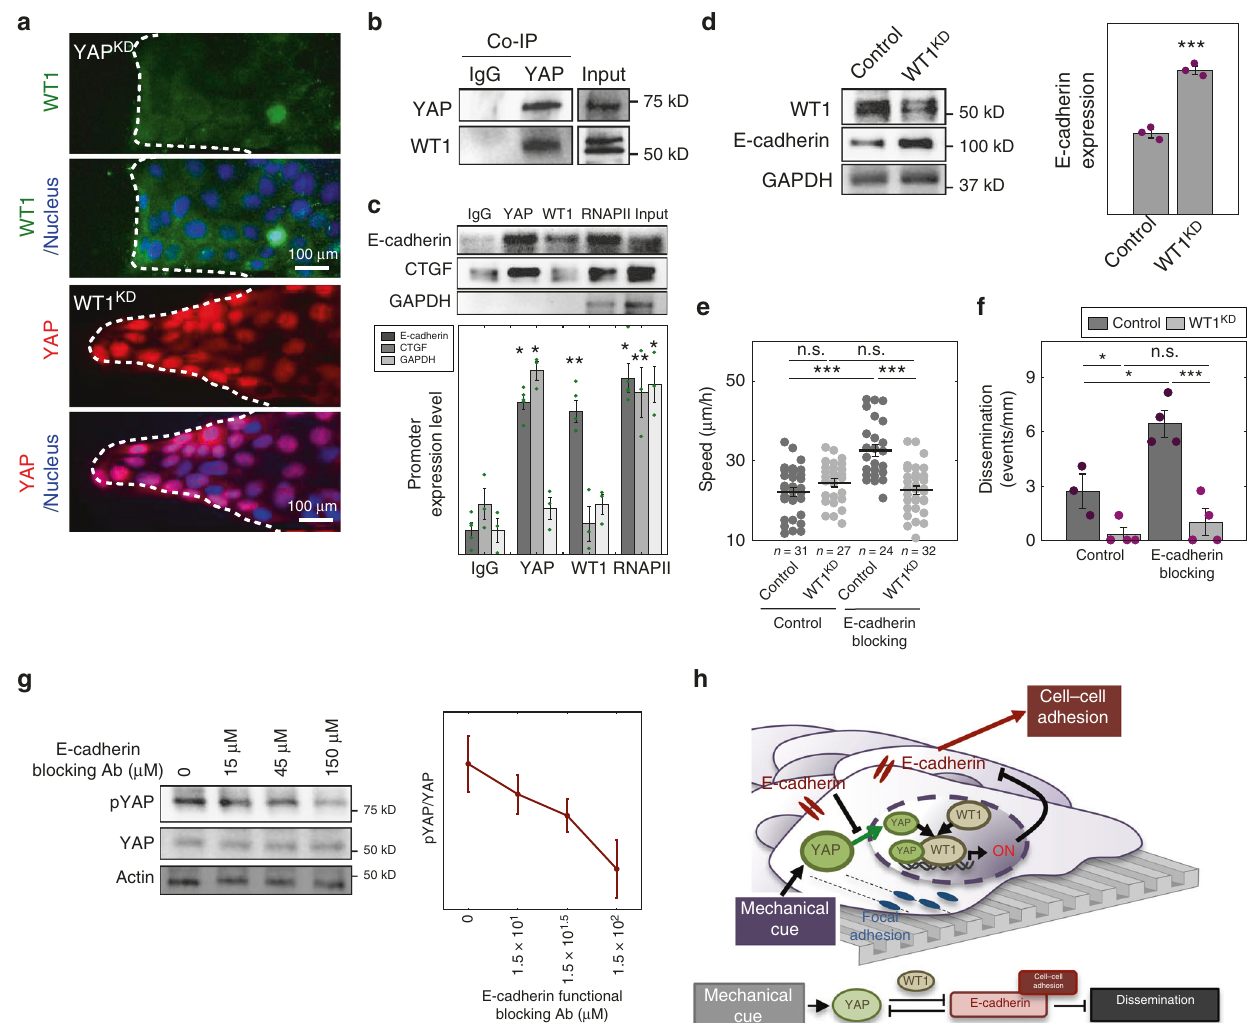
Fig. 4 YAP regulates E-cadherin through WT1 in epithelial layers on NRA. a Immuno fl uorescence staining for WT1 in YAP KD cell sheets (top), and for YAP in WT1 KD cell sheets cultured on NRA. The samples were fi xed after 8 h to remove stencils. b Co-IP analysis using the YAP antibody, followed by immunoblotting using the WT1 antibody. c Chromatin immunoprecipitation (ChIP) analysis of the WT1-YAP complex binding at the E-cadherin promoter ( n = 3). We extracted cross-linked chromatin and immunoprecipitated it using antibodies against YAP, WT1, IgG (negative control), and RNAPII or histone H3 (see Supplementary Fig. 12a) antibodies (positive controls). The immunoprecipitated chromatin and input genomic DNA were used for ampli fi cation of the E-cadherin promoter, CTGF promoter (known to be regulated by YAP but not WT1, and used as another control), and GAPDH promoter ( n = 4 biologically independent samples, * = statistical signi fi cance of PCR products from each sample vs. IgG, * P < 0.05 and ** P < 0.01). d E-cadherin expressions of control and WT1 KD cells analyzed by immunoblotting with WT1 and E-cadherin antibodies ( n = 3 biologically independent samples, * = statistical signi fi cance of E-cadherin expression of control and WT1 KD cells, *** P < 5 × 10 − 3 ). e Cell migration speed of individual cells in control and WT1 KD epithelial cells in the marginal region of the sheets in the presence of an E-cadherin blocking antibody (each number of independently analyzed cells, n , is indicated, * = statistical signi fi cance, n.s = no signi fi cance, and *** P < 5 × 10 − 3 ). f Dissemination of cells in control and WT1 KD epithelial sheets on NRA in the presence of an E-cadherin blocking antibody ( n = 4 biologically independent experiments, * = statistical signi fi cance, * P < 0.05, *** P < 5 × 10 − 3 , and n.s = no signi fi cance). g Immunoblotting of phosphorylated YAP and total YAP in cell sheets cultured in the presence of different concentrations of E-cadherin blocking antibody ( n = 3 biologically independent samples). h Schematic of the YAP-mediated cell dissemination triggered by mechanical cues stemming from NRA, operating through E-cadherin control by YAP-WT1 complexes and leading to cell dissemination in epithelial cell sheets on NRA. All error bars are S.E.M and statistical signi fi cance was determined by two-sided Student ’ s t